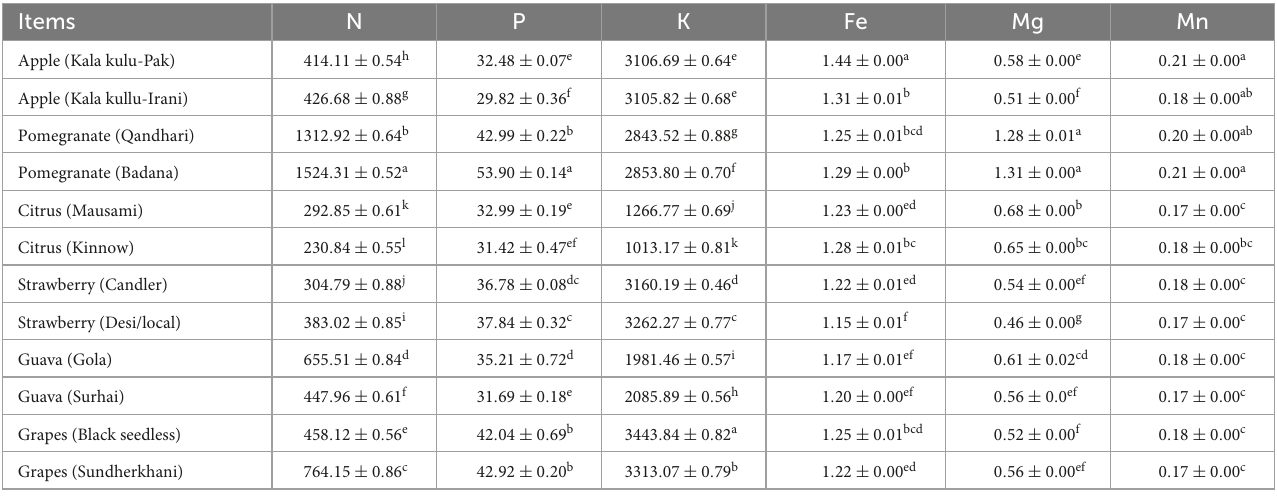
TABLE 4 The mineral profile of different fruit peel varieties.